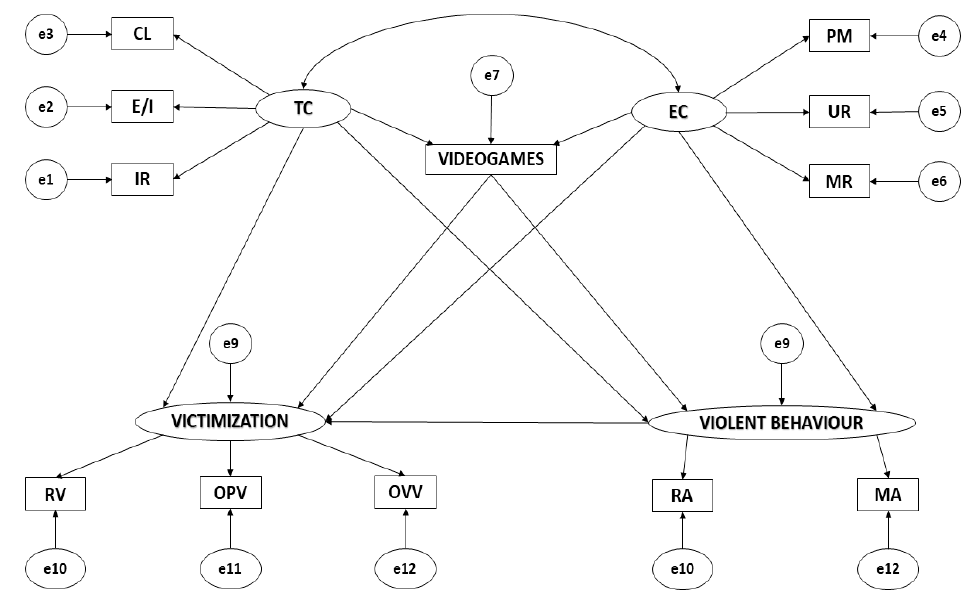
Figure 1. Theoretical Model. Note: TC, task climate; CL, cooperative learning; E/I, effort/improvement; IR, important role; EC, ego climate; ITR, intra-team rivalry; PM, punishment of mistakes; UR, unequal recognition; VIDEOGAMES, use of videogames; VICTIMISATION, victimisation; RV, relational victimisation; OPV, overt physical victimisation; OVV, overt verbal victimisation; VIOLENT BEHAVIOUR, violent behaviour; MA, manifest aggressiveness; RA, relational aggressiveness.